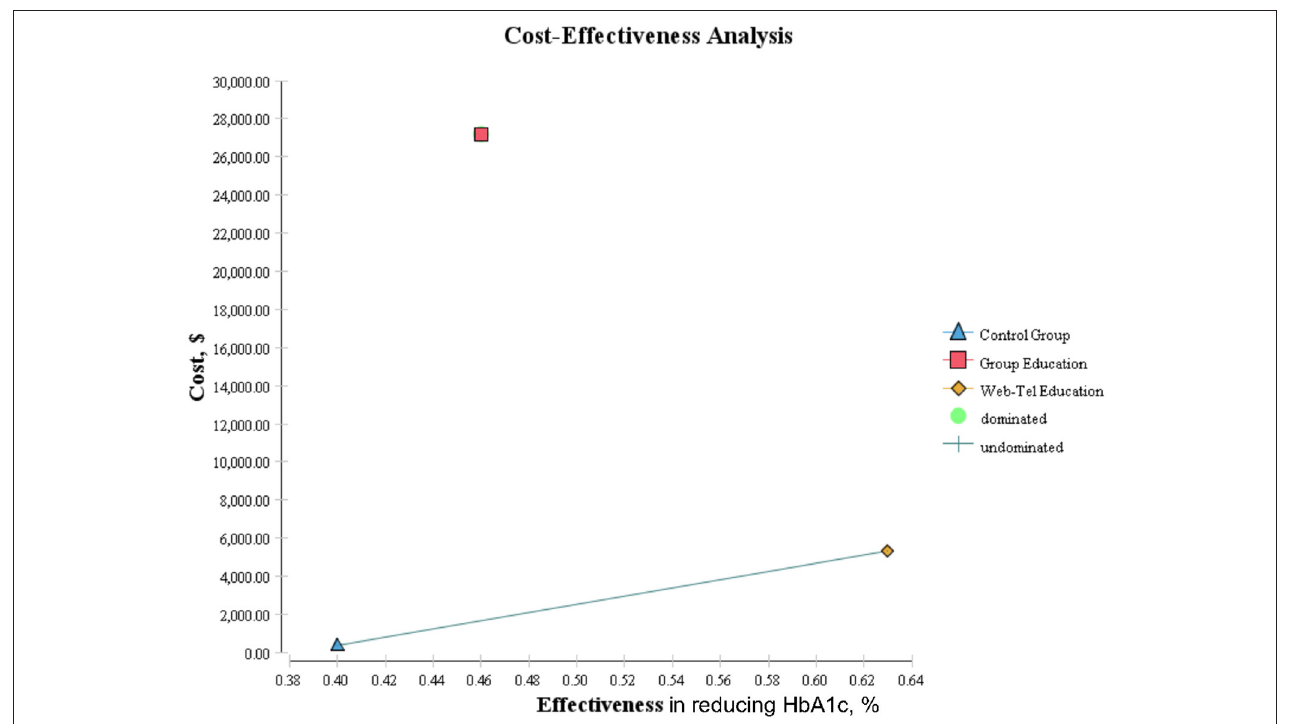
FIGURE 2 | Comparison of cost-effectiveness analysis among three groups of patients with type 2